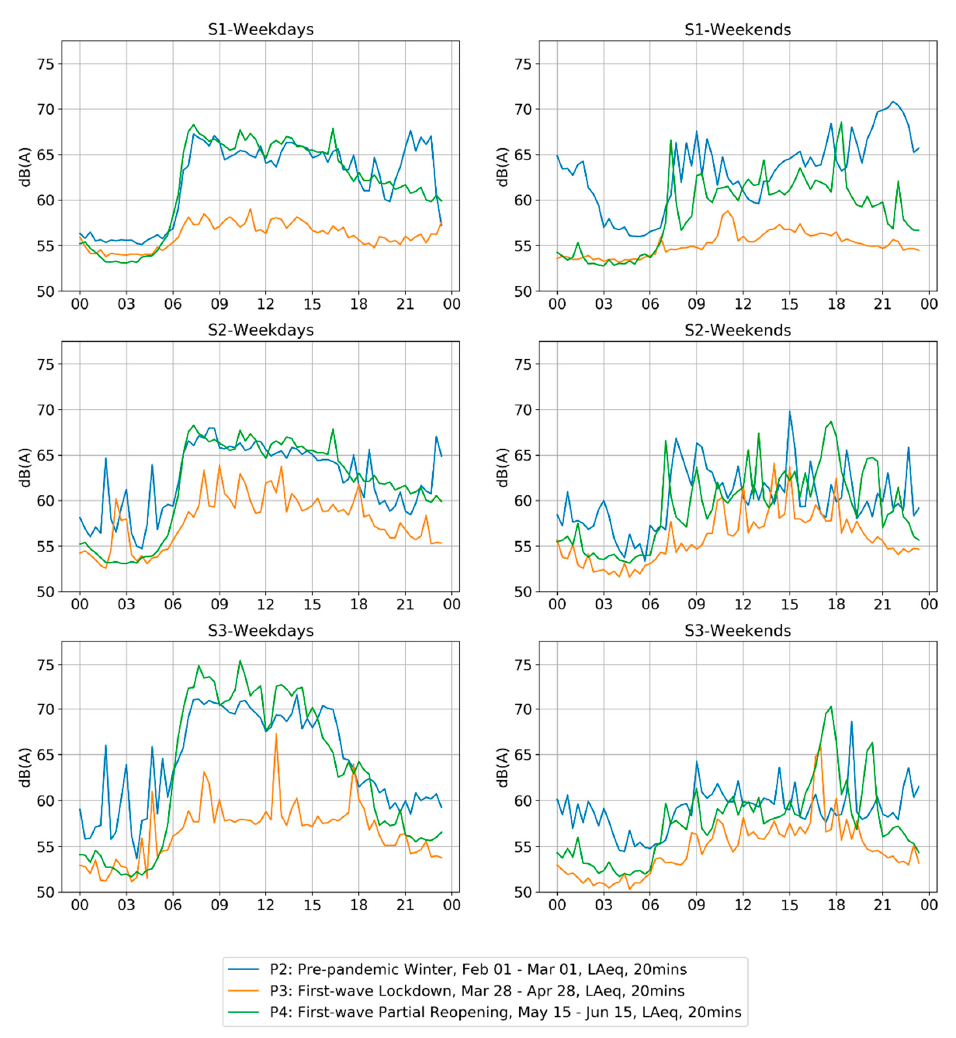
Figure 5. A comparison of levels throughout the day (L eq,20min ) on weekdays and weekends, averaged across each weekday and weekend day over four representative weeks from each period (P2: Pre-pandemic winter P2; P3: First-wave Lockdown; P4: First-wave Partial Reopening. Analysis shows a clear difference in the daily profile between each condition. Distinctions between the weekday and the weekend that were previously clear are diminished.